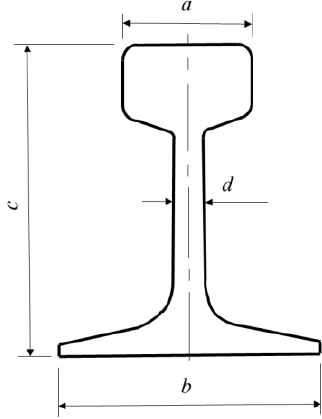
Figure 6. Dimension of the standard rail.